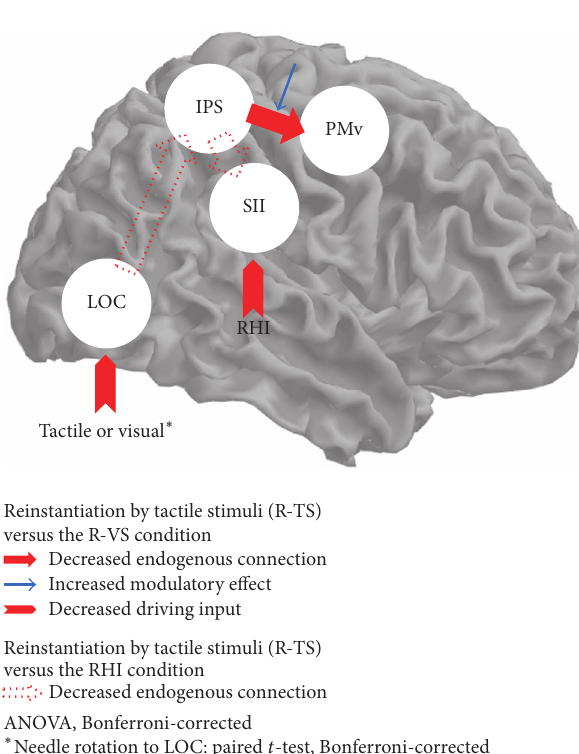
Figure 4: Significant changes in DCM parameter estimates during the R-TS condition versus the RHI (dotted-line arrow) and sig- nificant changes in DCM parameter estimates during the R-TS condition versus the R-VS condition (solid-line arrow). One-way analysis of variance (ANOVA) and Bonferroni post hoc analyses were used, and the Bonferroni correction was applied for multiple comparisons, except for the driving input of mechanical stimulation to the LOC ( ∗ ). As mechanical stimulation (tactile or visual stimuli) was modeled in two DCM analyses, paired t -tests with a Bonferroni correction were